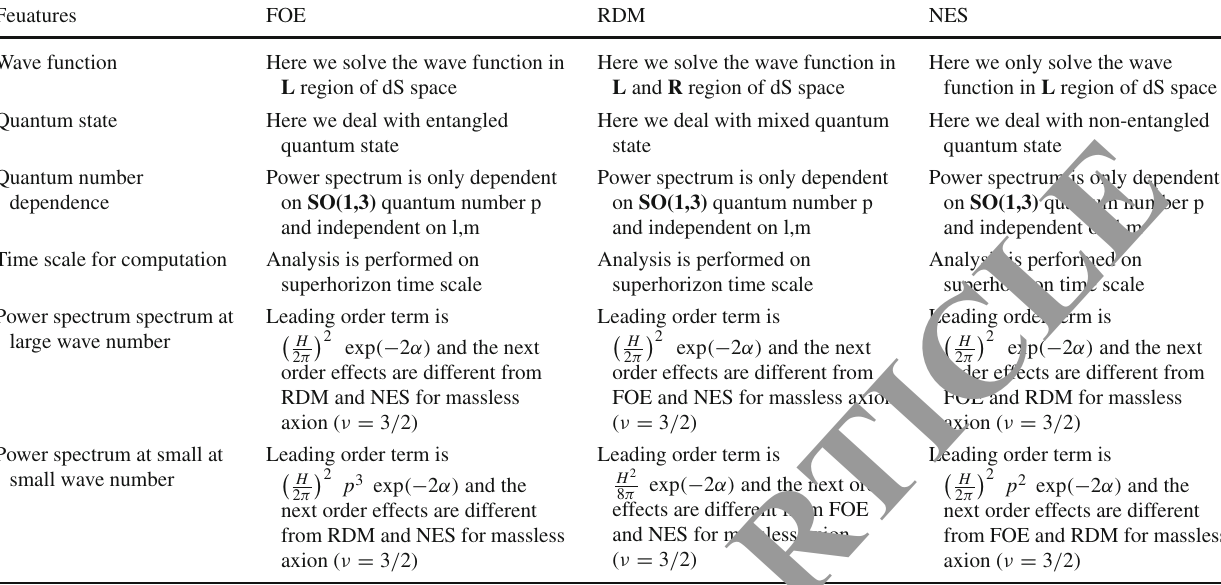
Table 1 Comparison between FOE, RDM and NES formalism for α vacua Feuatures FOE RDM NES Wave function Here we solve the wave function in L region of dS space Quantum state Here we deal with entangled quantum state Quantum number Power spectrum is only dependent dependence on SO(1,3) quantum number p and independent on l,m Time scale for computation Analysis is performed on